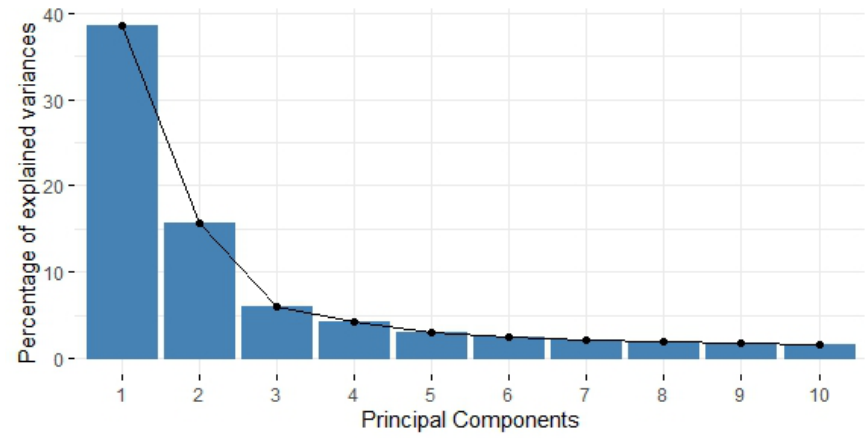
Figure 6. Percentage of variables explained by each principal